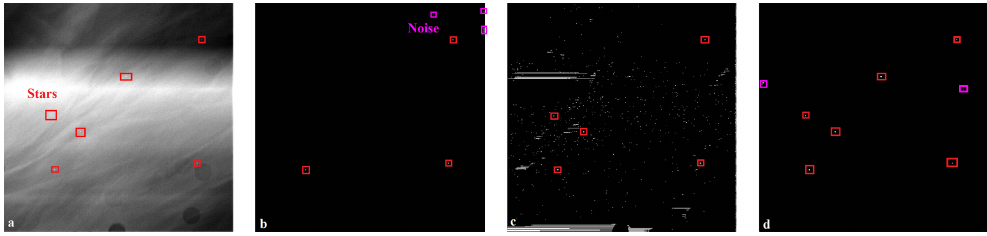
Figure 13. E and B EXperiment mission [44] star camera’s image detail segmentation: ( a ) real image;